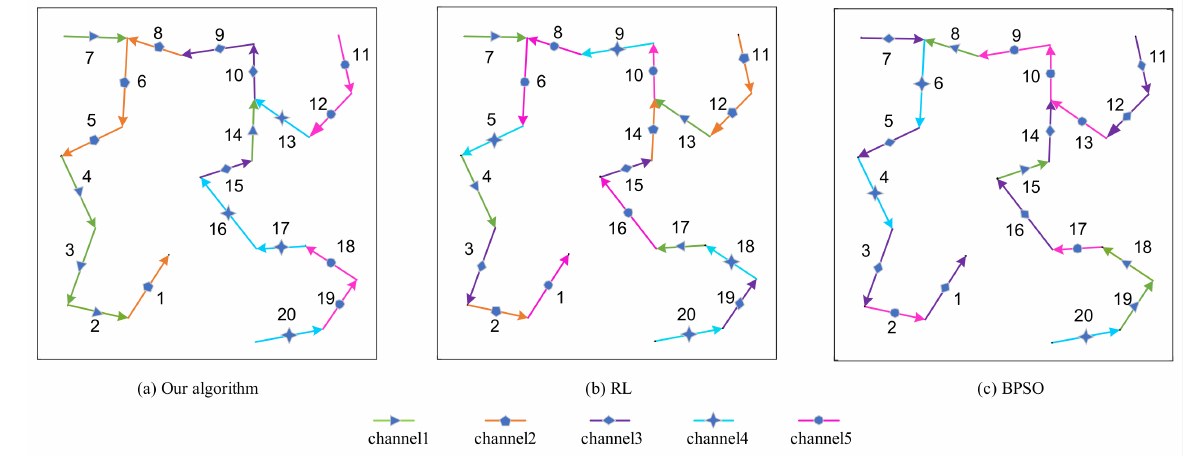
Figure 9. Network channel